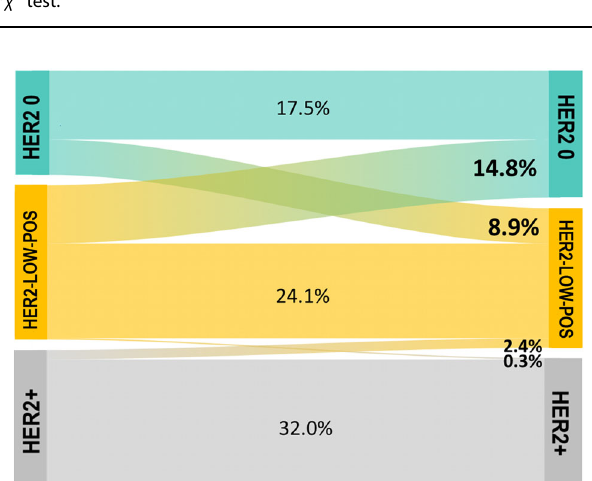
Fig. 3 Evolution of HER2 expression. This Sankey diagram shows the evolution of HER2 expression from baseline biopsy to residual disease after neoadjuvant chemotherapy in patients failing to achieve